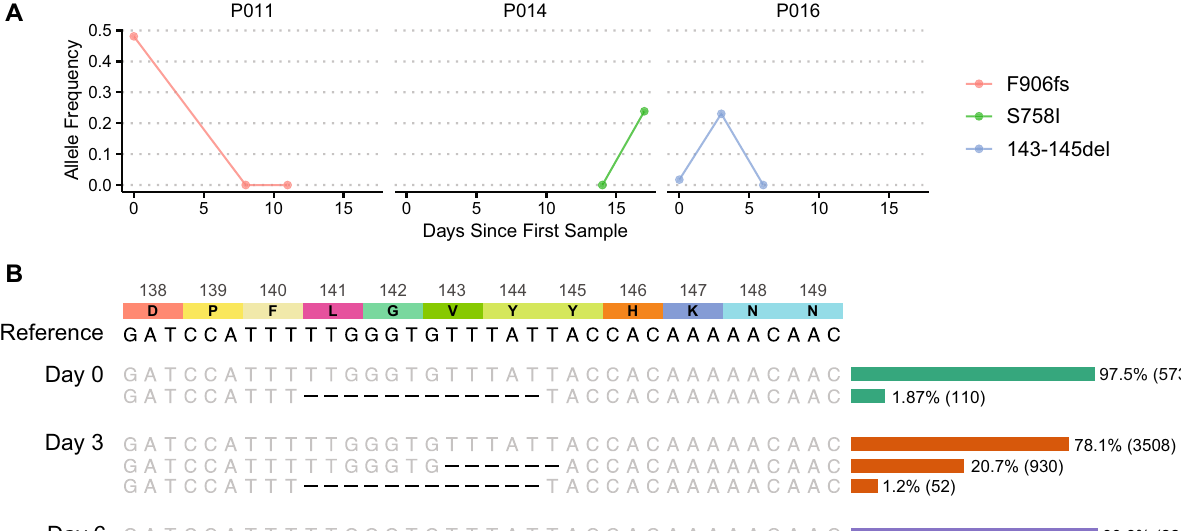
Figure 4. Variants that exhibit intra-host evolution in the spike protein across all patients. ( A ) All non- synonymous variants located in the spike protein with a ≥ 20% change in allele frequency among timepoints for any patient. ( B ) Enumeration of deletions that arose between residues 138–149 of the spike protein in P016 at ≥ 1% relative frequency reveals a rapidly changing complement of low frequency alleles present over a 6-day period. The reference nucleotide sequence (NC_045512) is located at the top of the sequence alignment. Above the reference is the corresponding amino acid sequence with associated residue numbers. Alleles that match the reference are in gray, and deletions are shown in black. To the right of the sequence alignment is a bar graph showing the square root of the relative frequency of each variant, for visualization purposes, labeled with the allele frequency in percentage and read depth in parentheses.